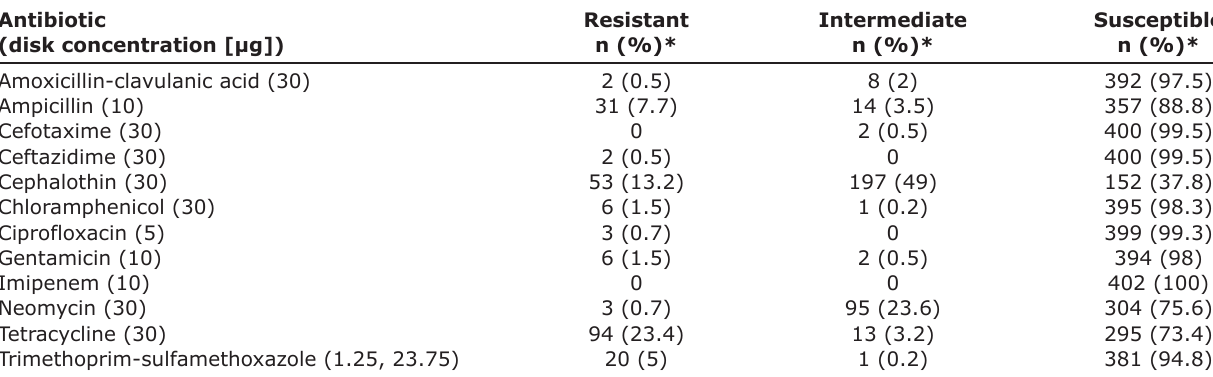
Table-1: Antibiotic susceptibility profiles of 402 Escherichia coli isolated from feces of non-diarrheic owned dogs in Grenada. Antibiotic (disk concentration